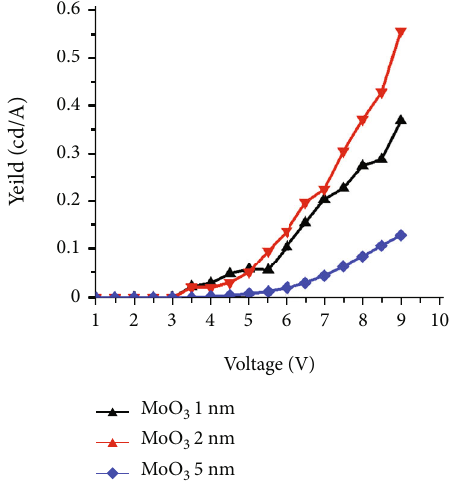
Figure 8: TE-OLED current e ffi ciency-voltage characteristic curve with variable MoO thickness. 3